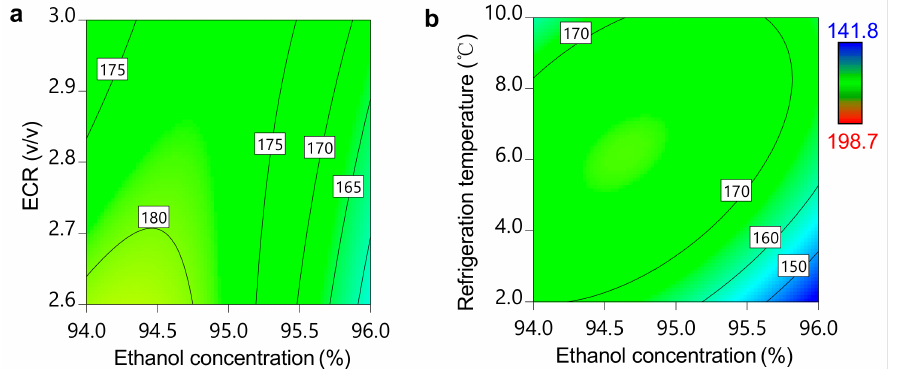
Figure 7. Contour plot of the extracted amount of total solids. ( a ) Density of concentrated extract was 1.23 g/cm 3 , stirring time after ethanol addition was 90 min, refrigeration temperature was 6 ◦ C. ( b ) Density of concentrated extract was 1.23 g/cm 3 , ECR was 2.8 v / v , stirring time after ethanol addition was 90 min.